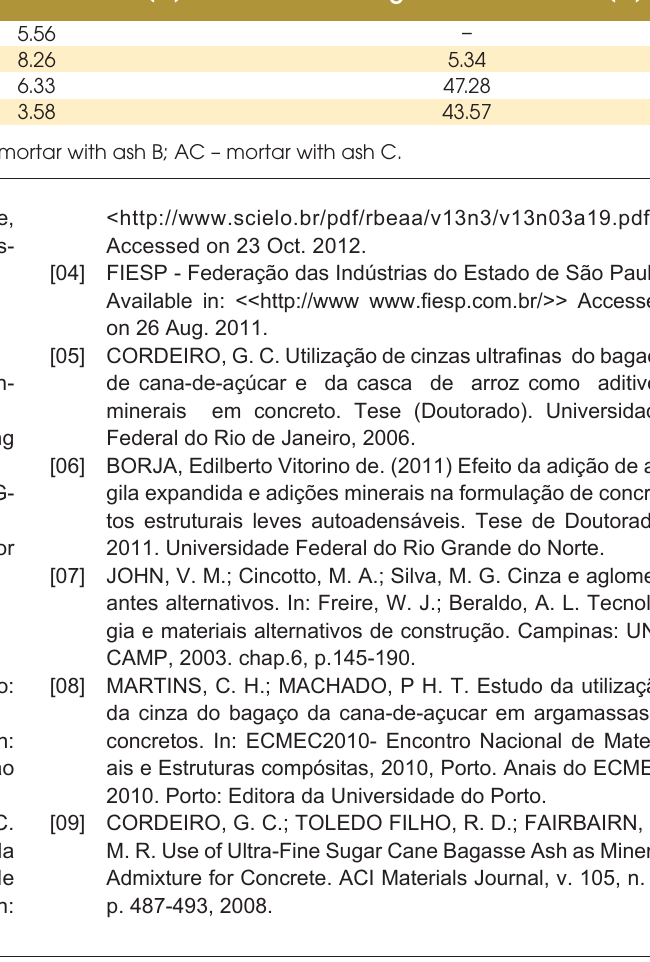
Table 5 – Compressive strength of mortars with ashes Sample